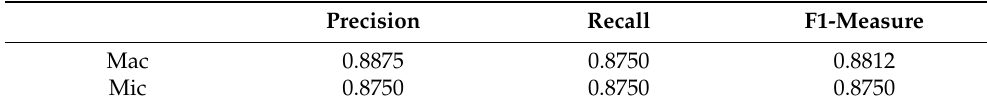
Table 5. Model evaluation